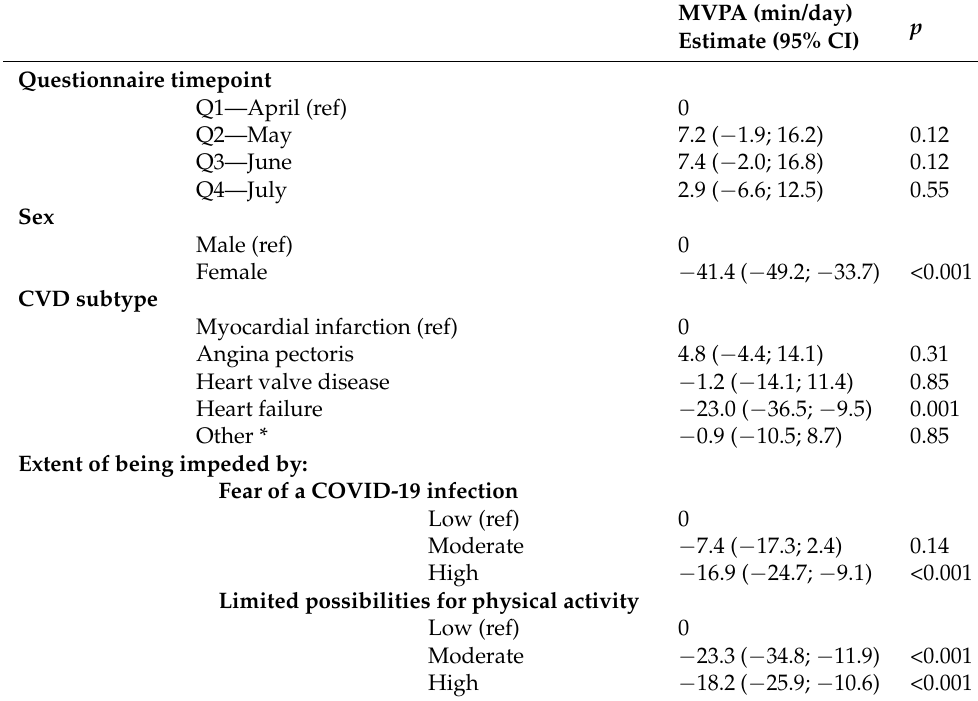
Table 1. Final multivariate mixed model for changes in moderate-to-vigorous physical activity (MVPA) during the first-wave COVID-19 lockdown period, adjusted for confounding factors. Data were reported as estimate (95% confidence interval